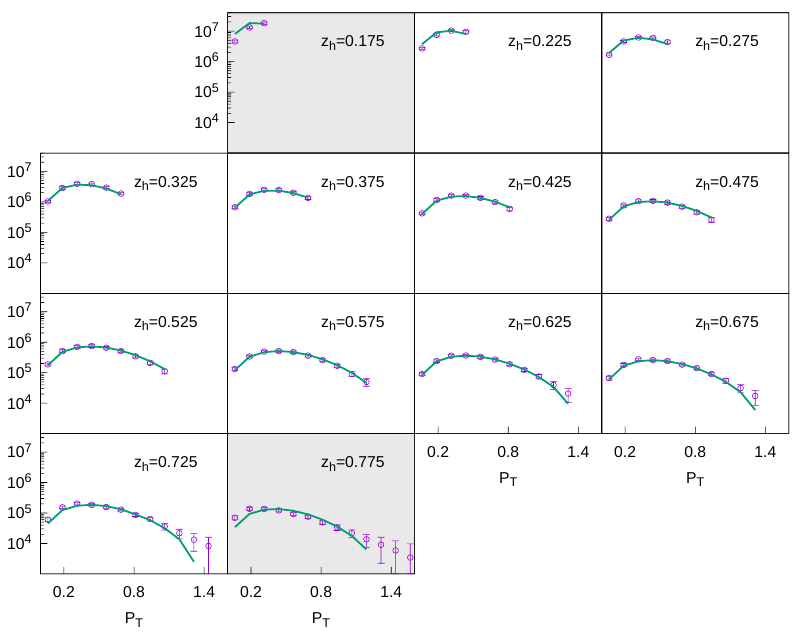
Figure 4: Cross section as a function of P Data in the shaded boxes are not included in the